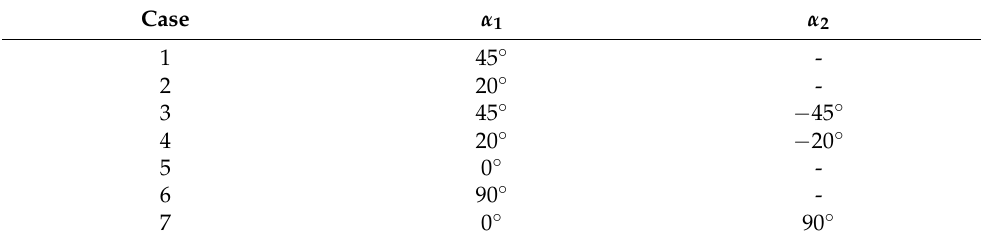
Table 1. Table summarizing the geometry parameters for the S 1 simulation